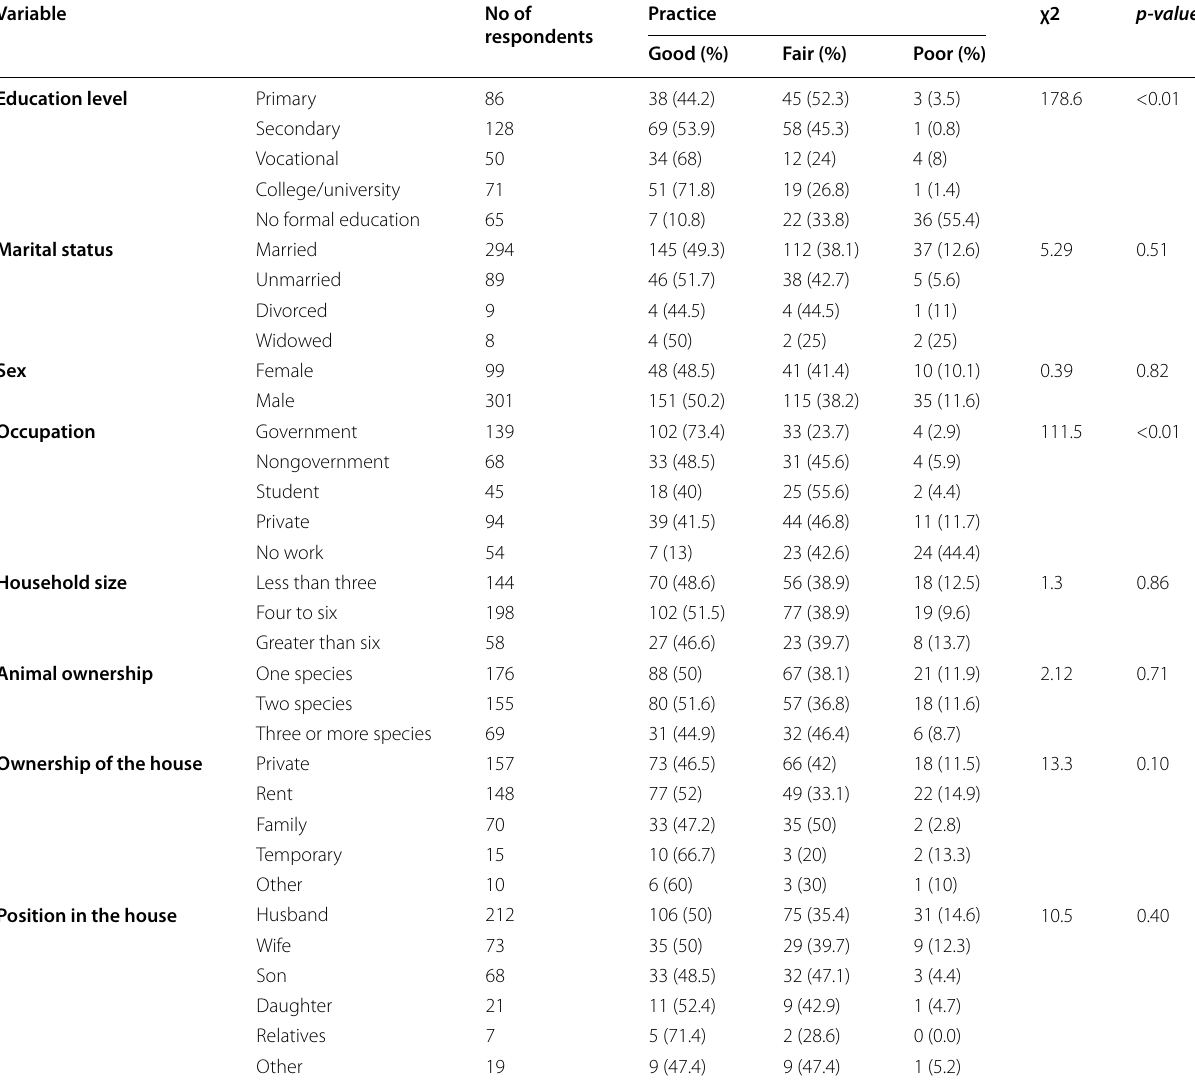
Table 7 Association of practice with demographic characteristics